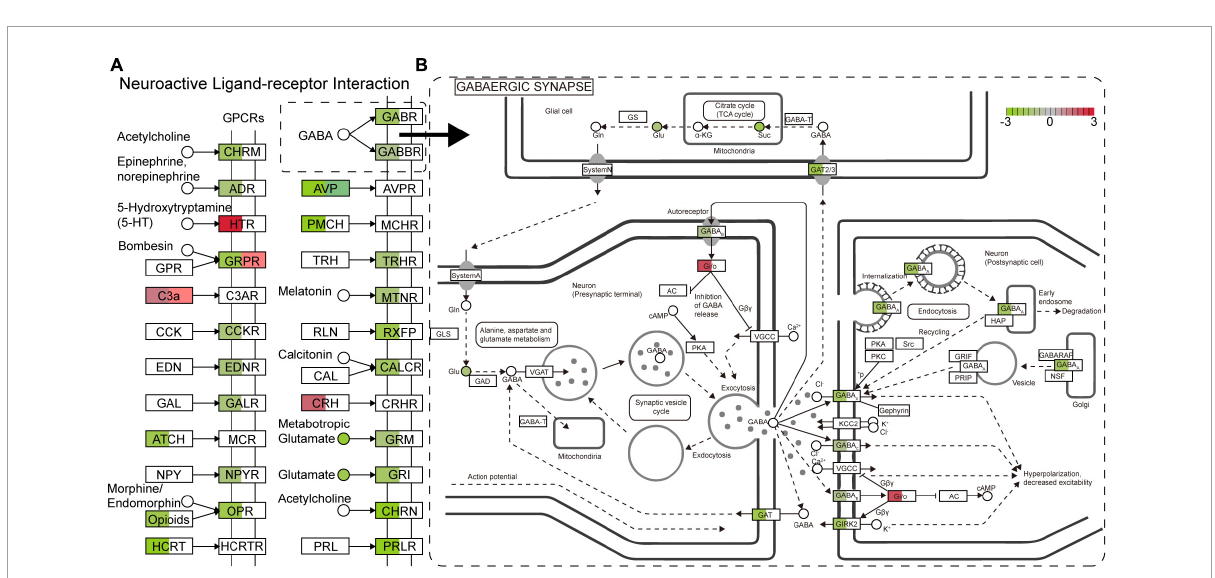
FIGURE7 The main enrichment pathway neurologyactive ligand-receptor interaction (A) and GABAergic synapse (B) in the TBSI group. Red: up-regulated; green: down-regulated. is a gene or protein, the color shows the expression change of the gene (Left) or protein (Right). ◦ is a metabolite. (cid:50)